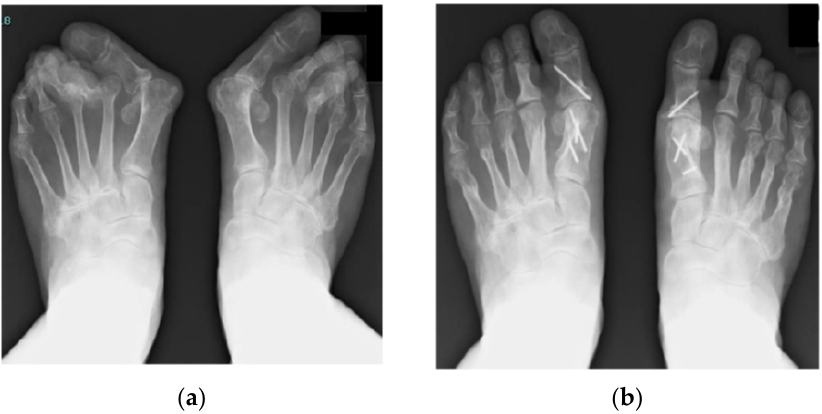
Figure 1. Representative case of a 75-year-old woman with a 40-year history of RA. ( a ) Preoperative radiograph with weight-bearing. Severe hallux valgus deformity, subluxation/dislocation of the lesser toe MTP joints, and joint erosion are seen. ( b ) Postoperative radiograph with weight-bearing 7 years after surgery. Combination surgery of modified scarf osteotomy and metatarsal shortening offset osteotomy has been performed. Akin osteotomy was also added to control the rotation and alignment. Painful callosity disappeared, and correction has been maintained 7 years after surgery. She can run at present.